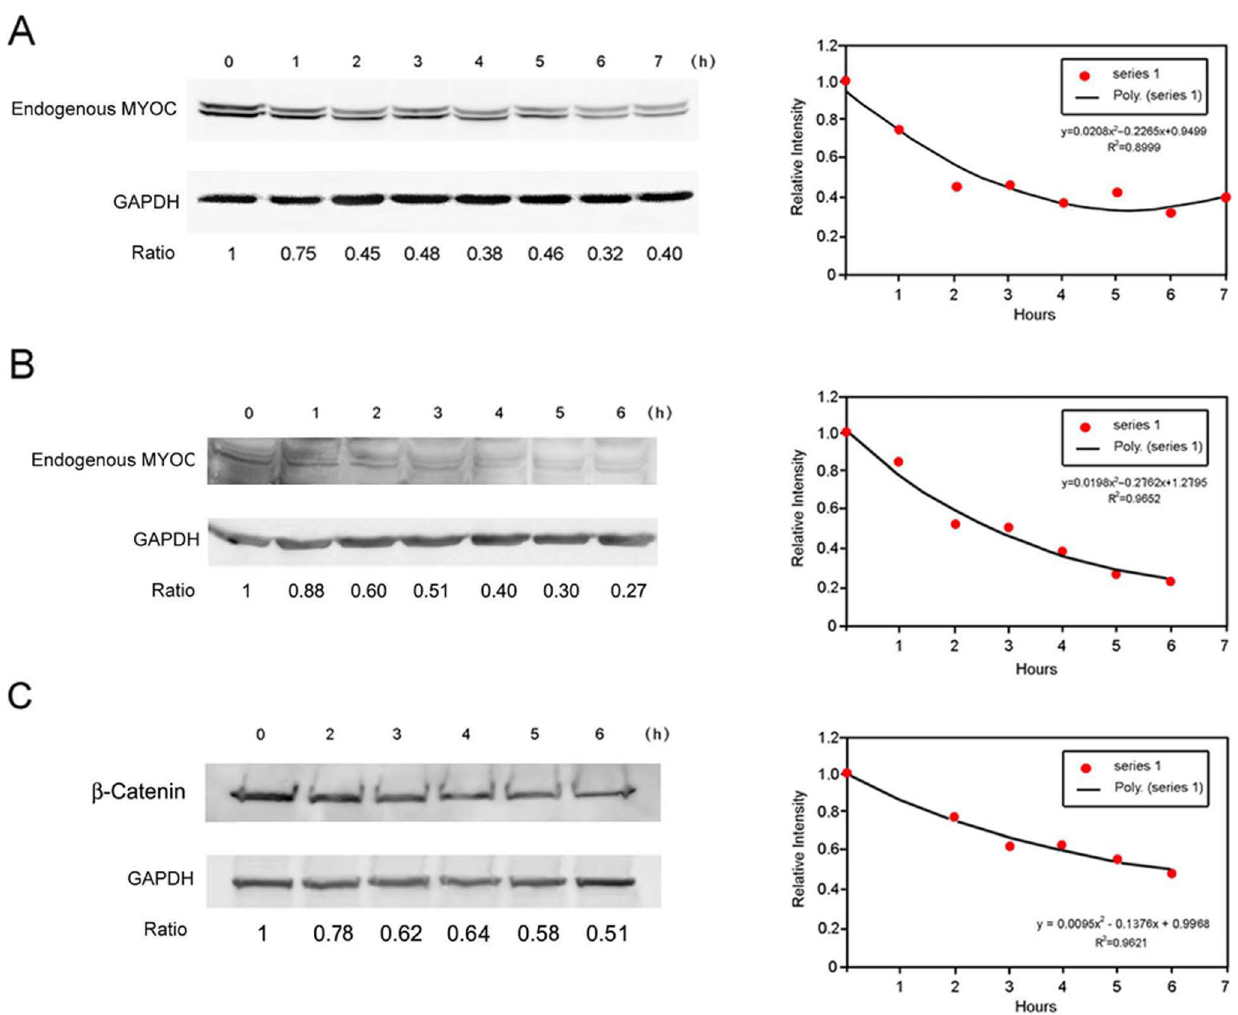
Figure 1. Turnover of the endogenous myocilin protein and b -catenin. A . Human TM cells from different donors were treated with CHX (5 m g/ml) and monesin (2 m M). Cells were harvested at various time points thereafter and the level of endogenous myocilin was determined by Western blotting. The GAPDH level was used for protein loading control. The level of the endogenous myocilin was dropped to about 50% 3 h after CHX and monesin treatment, indicating that myocilin is a short-lived protein. One representative experiment is presented. Ratios between levels of the endogenous myocilin and those of GAPDH are presented (left panel), which were plotted against time to estimate the myocilin half-life (right panel). B . The turnover of the endogenous myocilin in RGC5 cells. Experiments were done as described in A . The half-life was estimated to be about 3 h. C . The turnover of b -catenin, a known short-lived protein, in RGC5 cells. Its half-life was found to be approximately 6 h, comparable to that reported previously [41]. Experiments were repeated at least 3 times, yielding similar